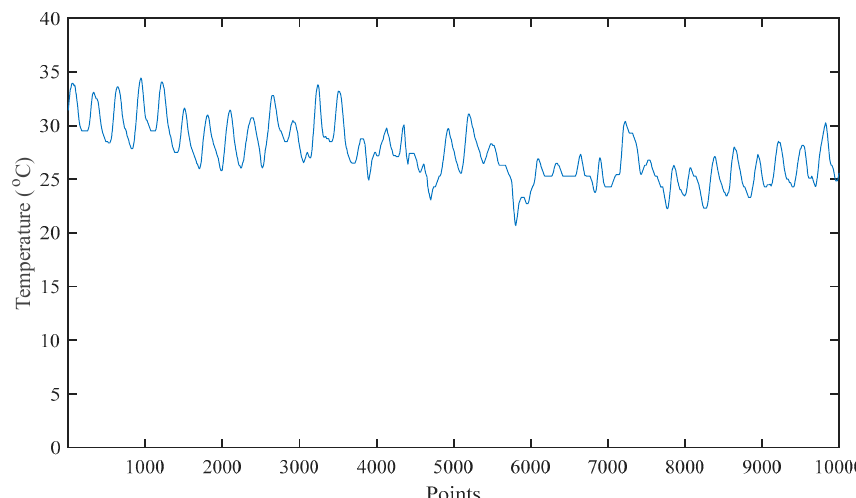
Figure 14. Actual ambient temperature in the wind farm (Case 2).